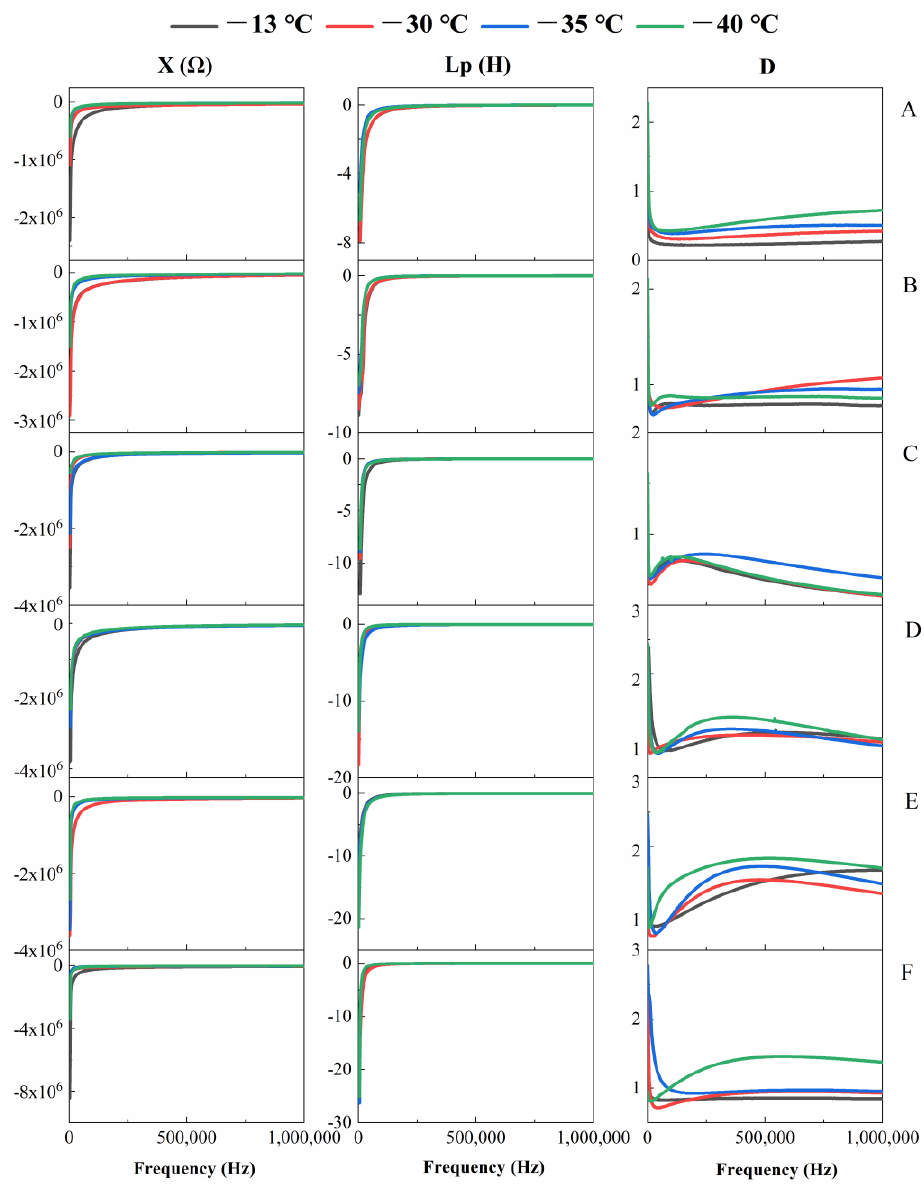
Figure 6. Effects of different freezing times and temperatures on the parallel equivalent reactance X, parallel equivalent inductance Lp and loss coefficient D of sea buckthorn berries. (( A ), 0 d; ( B ), 15 d; ( C ), 30 d; ( D ), 45 d; ( E ), 60 d; ( F ), 75 d). The data are mean values of five replicates.